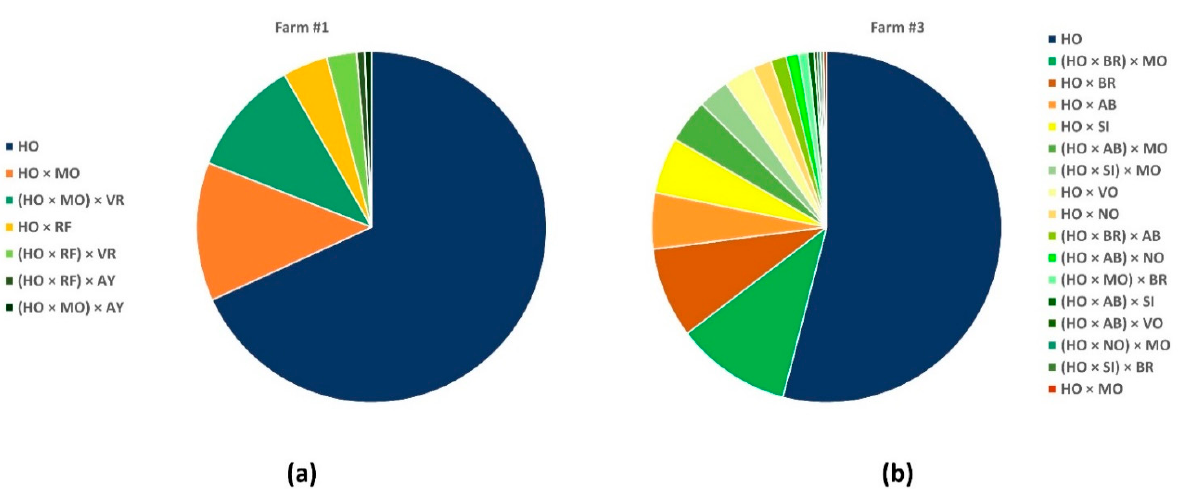
Figure A1. Different breed combinations for lactations data in dataset 1 among two herds of the 14-herd sample: ( a ) farm #1 and ( b ) farm #3. HO = purebred Holstein; AB = Abondance; AY = Ayrshire; BR = Brown Swiss; MO = Montbéliarde; NO = Normande; RF = Belgian Red; SI = Simmental; VO = Vosgienne; VR = Viking Red. Table A1. Description of the three datasets used for the statistical analyses of milk production (dataset 1), udder health performance (dataset 2) and reproduction performance (dataset 3). For each, the number of lactations and the number of cows for each genotype are indicated.